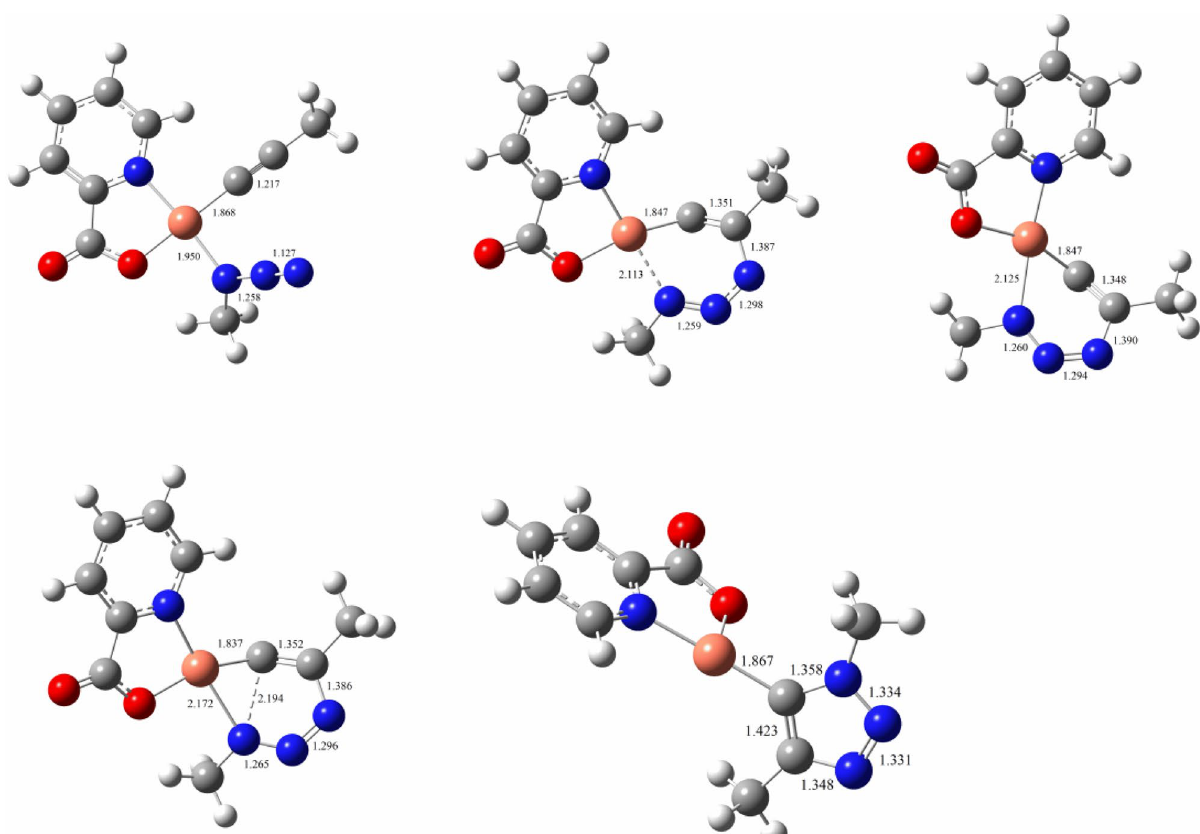
Figure 5. Optimized structures of TS 2/3 , TS 3/4 , and